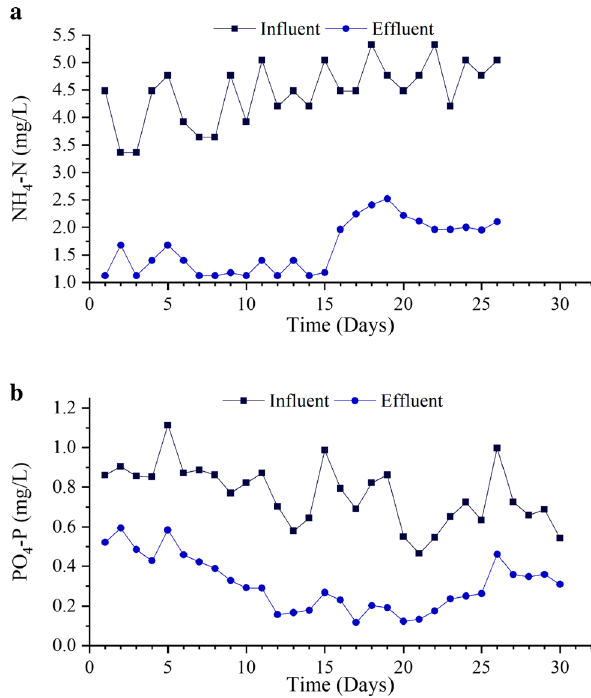
Fig. 3 Temporal variations in the influent and effluent greywater streams for a ammoniacal–nitrogen and b